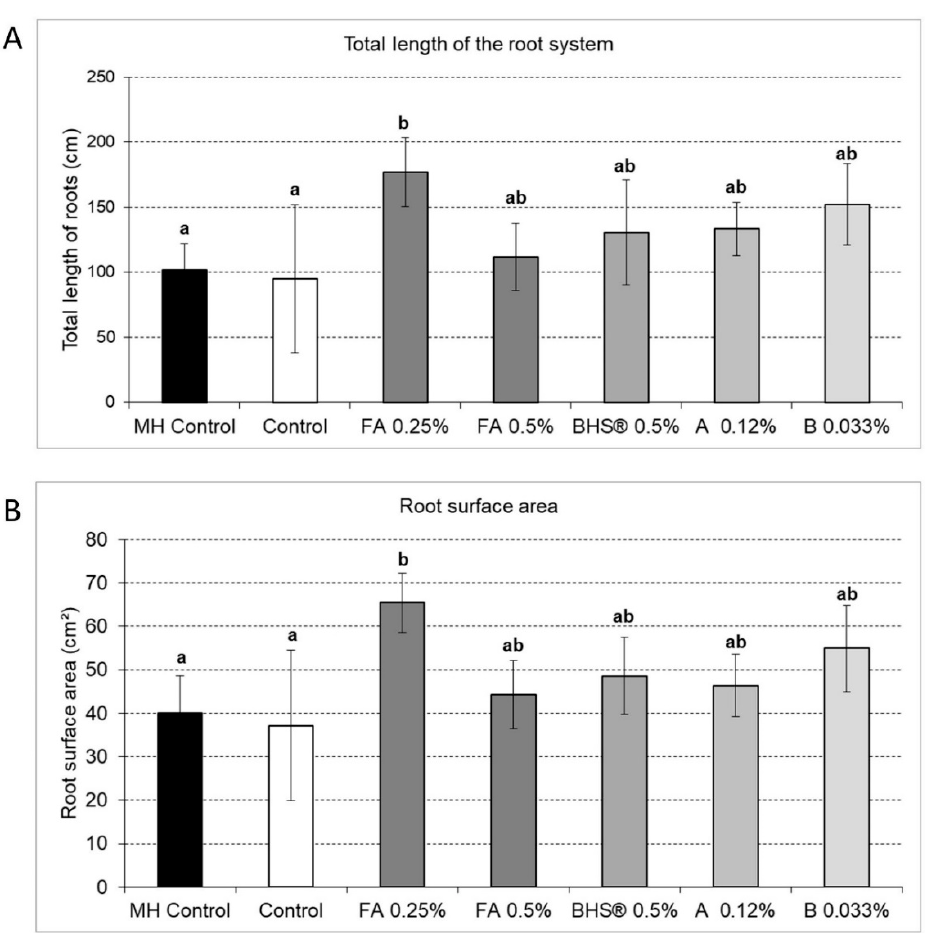
Figure 4. ( A , B ): Total length ( A ) and surface area ( B ) of Vicia faba roots after 56 h experimentation: non-exposed (Control) or exposed to 10 − 5 M Maleic hydrazide (MH Control), or to different commercial products: fulvic acids at 0.25% (FA 0.25%) or 0.5% (FA 0.5%), or biomimetic humic substances (BHS ® 0.5%) or product A or B. (Vertical bars indicate Standard deviation and histograms marked with the same letter are not statistically different at p < 0.05).